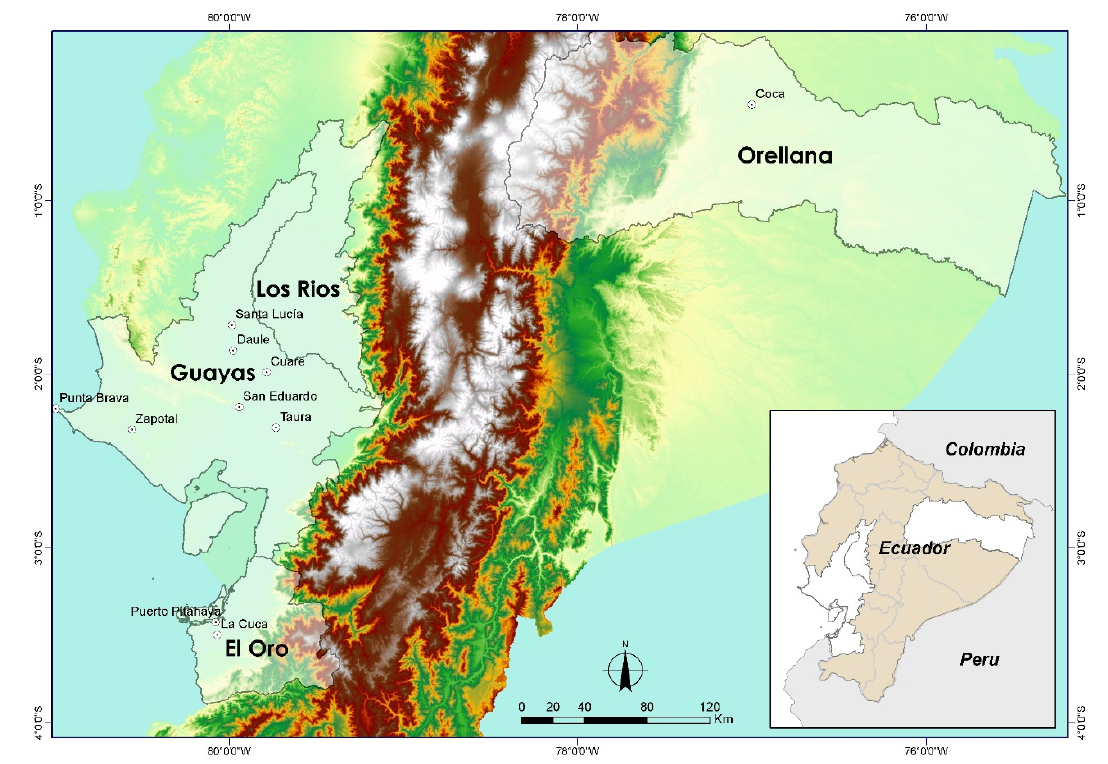
Figure 1. Location of the provinces of Ecuador where the sampling was carried out.